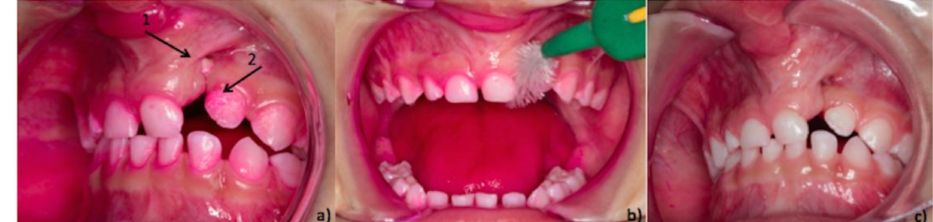
Figure 3. Intraoral photographs from a child with cleft lip and palate, Spina type I, (a complete cleft lip on the left side); ( a ) the teeth were stained to evidence the bacterial plaque, 1—food in the deep cleft, 2—The supernumerary is the tooth with more bacterial plaque on the surface; ( b ) brushing with the Cleft Toothbrush—the front bristles were used to enter the cavity of the cleft, combining rotation and translation movements; and ( c ) the mouth after brushing, showing the high efficacy in bacterial plaque